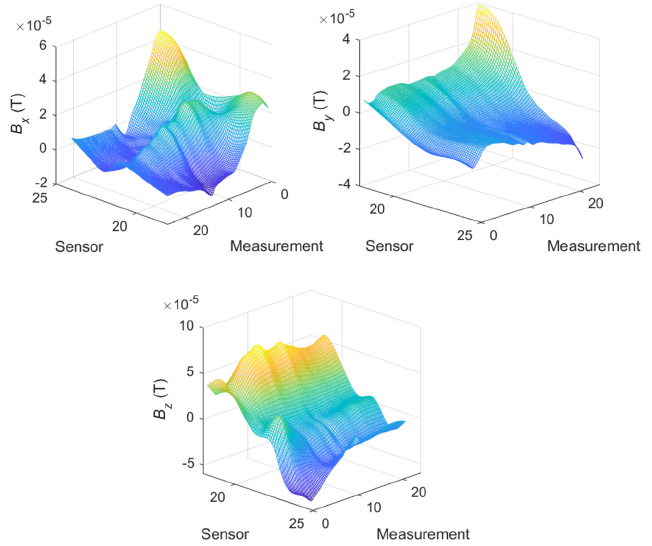
Figure 15. Distribution of the B magnetic induction for the broken arm of the specimen for successive states of the material’s stress.